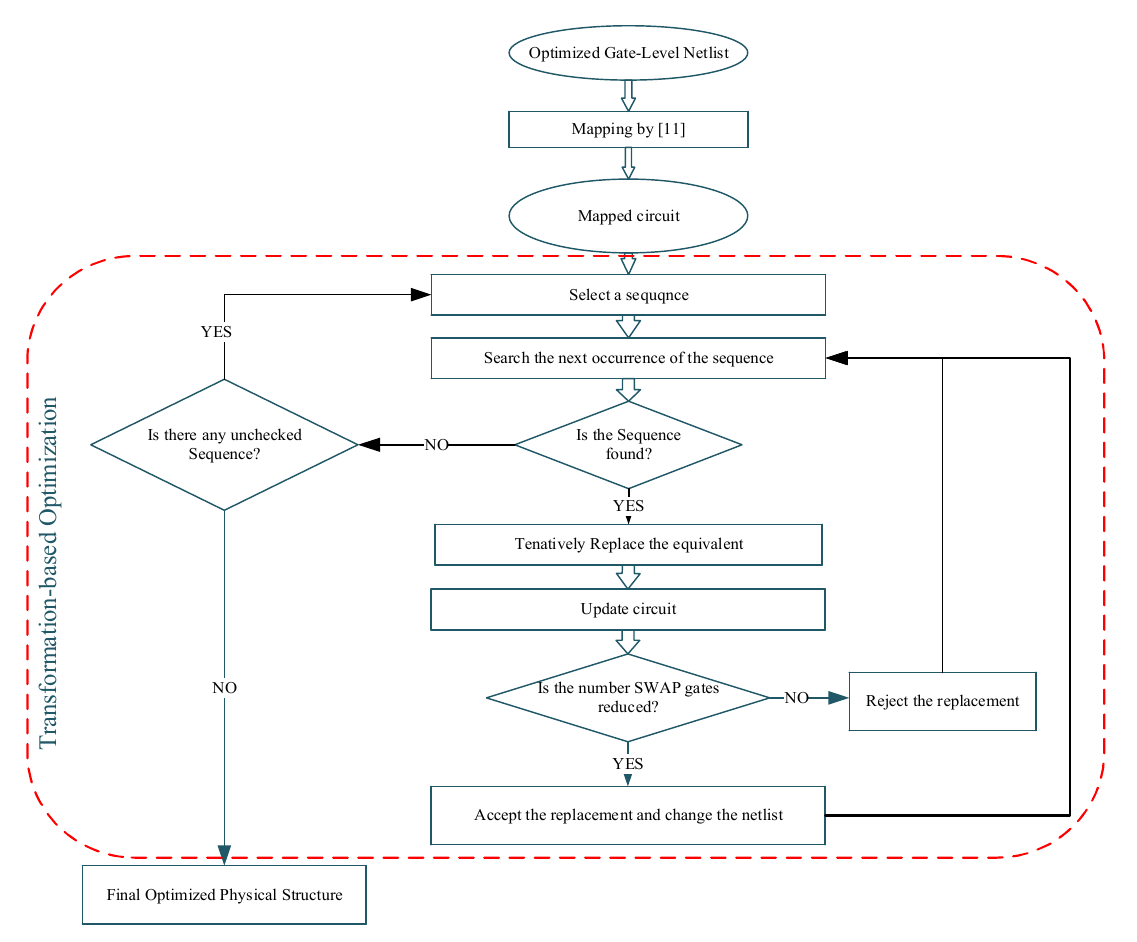
Figure 2. The proposed flow for applying transformations.